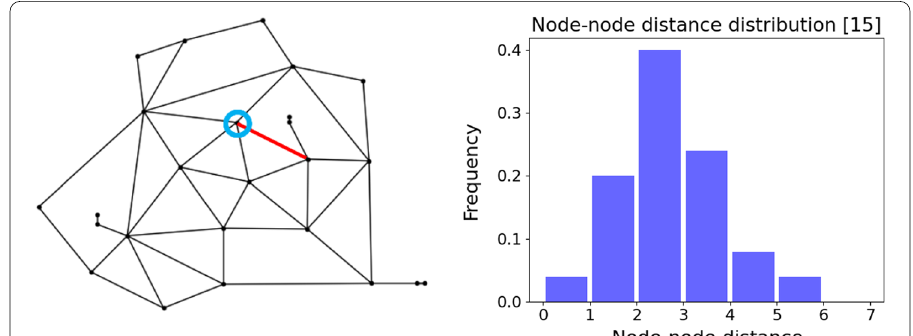
Fig. 1 A schematic representation of Anytown (left). The node–node distance distribution of node 15 (right), highlighted in light blue in the network